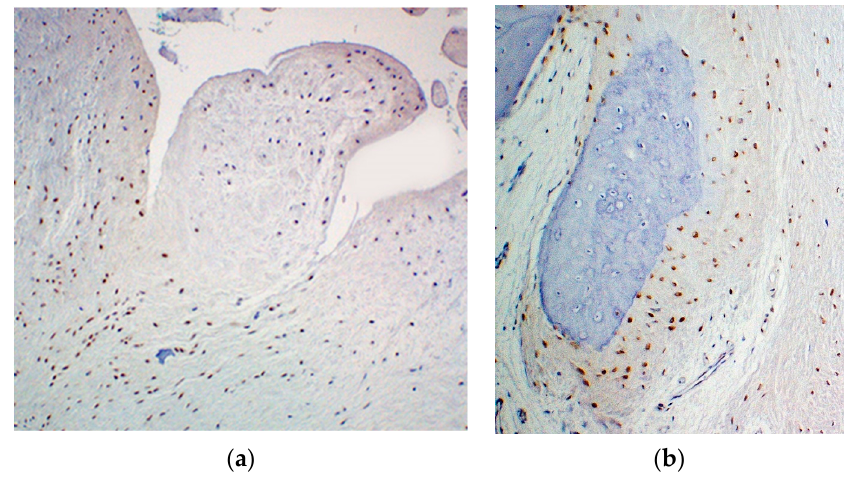
Figure 3. Immunohistochemical findings in patient 1. Gli1 was expressed in the nuclei of the neo- plastic cells ( a ), especially at the periphery of the cartilage nodule ( b ).